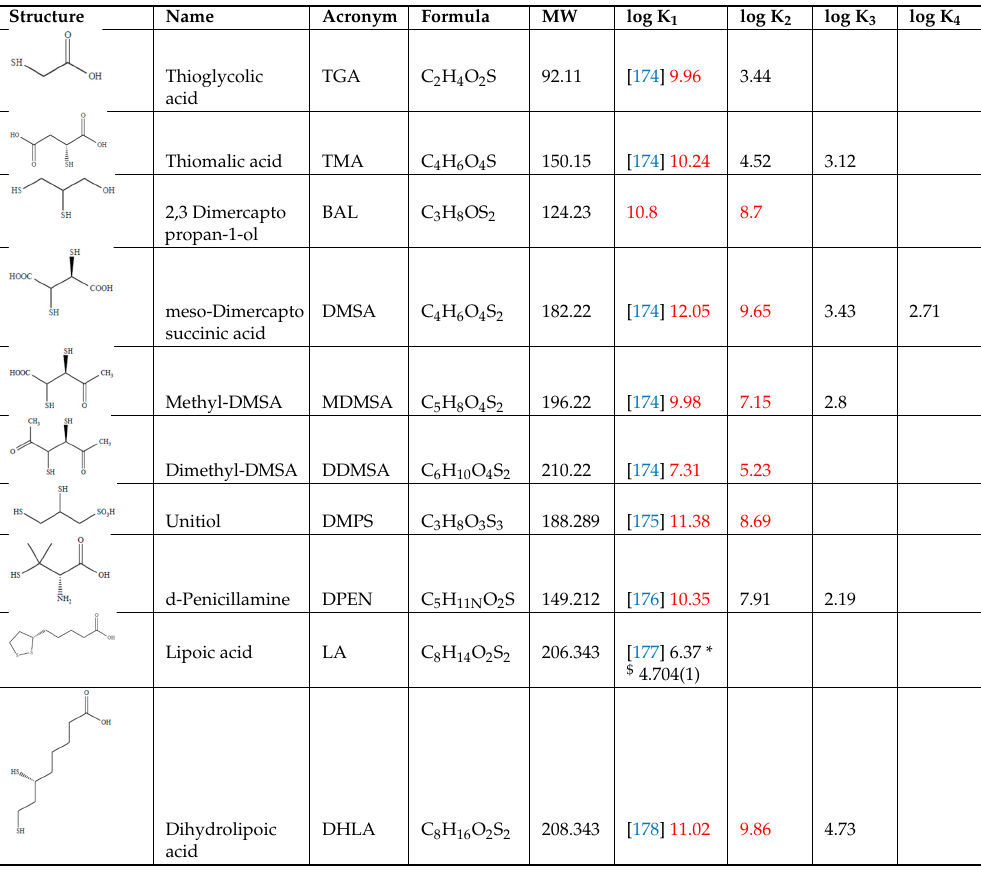
Table 3. Protonation constants of thioglycolic acid, thiomalic acid, meso-2,3-dimercaptosuccinic acid (DMSA), dimercaptopropane sulfonate (DMPS), penicillamine, lipoic acid, dihydrolipoic acid, and some other simple ligands useful to characterize the acid behavior of SH ligands.